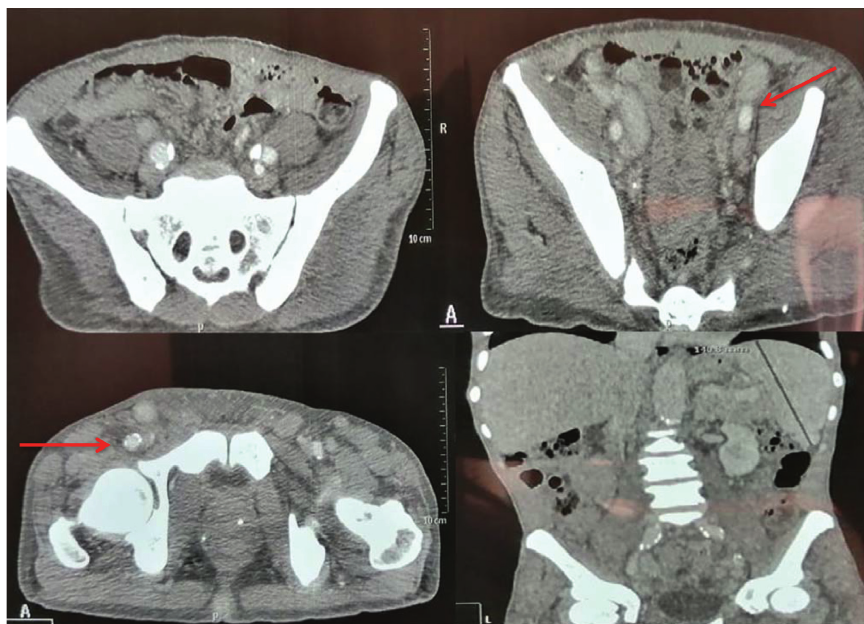
Figure 1: Multiple mediastinal and abdominal lymphadenopathies with central